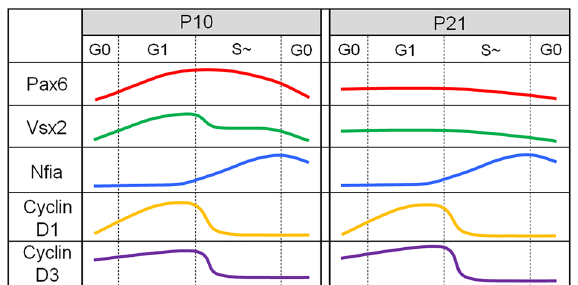
Figure 9. A schematic diagram summarizing expression patterns of RPC transcription factors and cell cycle regulators in dissociated Müller glia during cell cycle